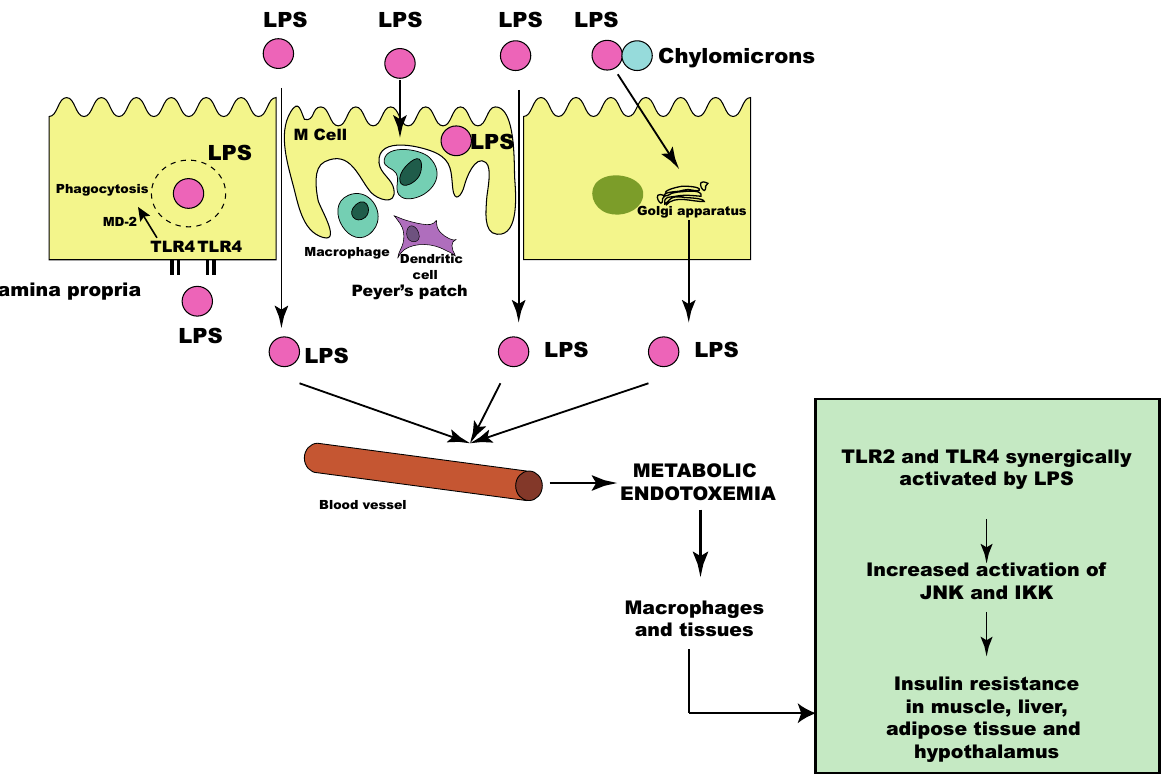
Figure 3. Metabolic endotoxemia leads to activation of insulin resistance in muscle, liver, adipose tissue and hypothalamus through activation of Toll-like receptor (TLR)2 and 4. JNK: c-Jun N -terminal kinase; IKK: IκB kinase; LPS: lipopolysaccharide; MD-2: myeloid differentiation factor-2. Figure